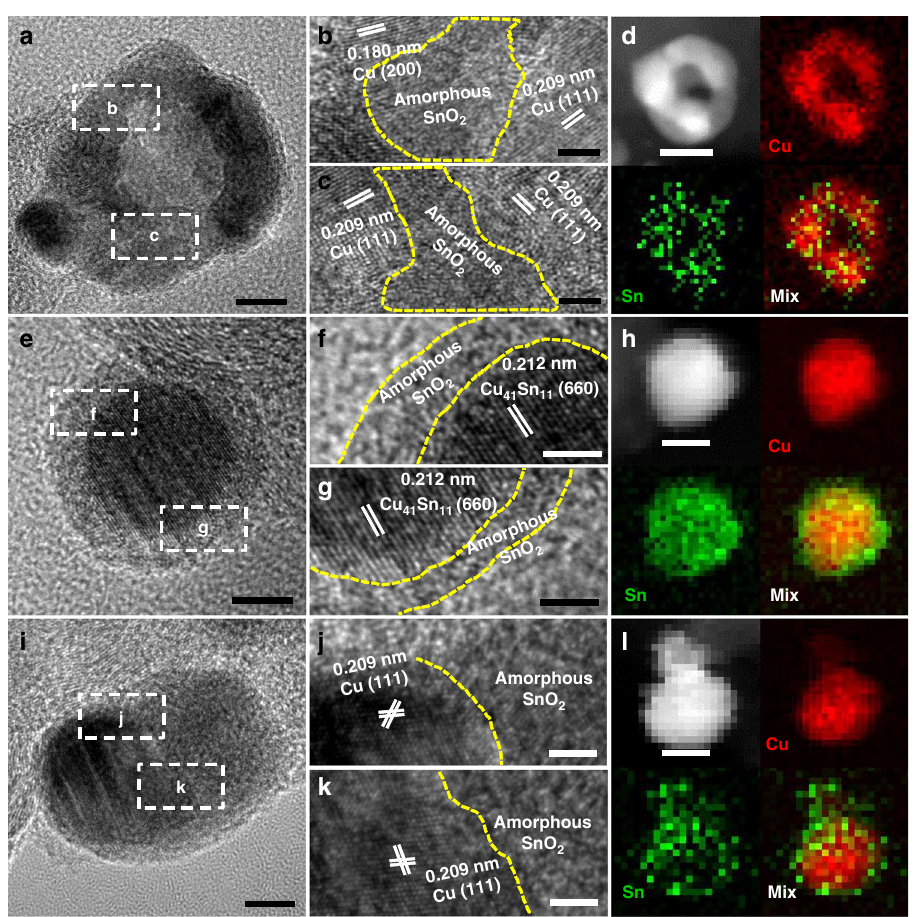
Fig. 5 Structure and interface characterizations of CuSn NPs/C-A-ACP, CuSn NPs/C-H-ACP, and CuSn NPs/C-AH-ACP. a , e , i High-resolution transmission electron microscopy (HRTEM) images, b , c , f , g , j , k magni fi ed HRTEM images, and d , h , l high-angle annular dark- fi eld scanning TEM (HAADF-STEM) image and energy-dispersive X-ray spectroscopy (EDS) elemental mappings of a – d CuSn NPs/C-A-ACP, e – h CuSn NPs/C-H-ACP, and i – l CuSn NPs/C-AH-ACP. Scale bars, 10 nm in d , h , l , 5 nm in a , e , i , 2 nm in b , c , f , g , j ,